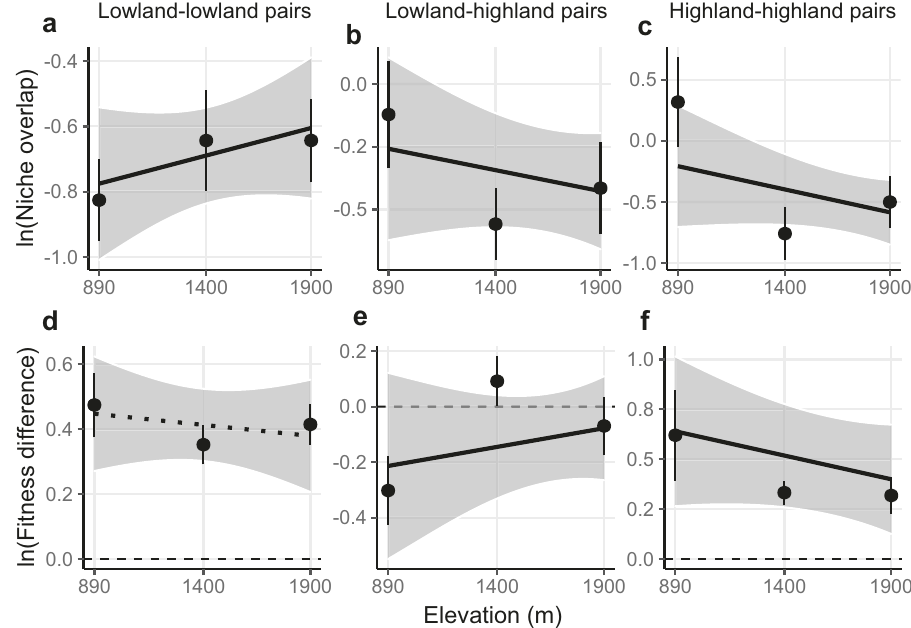
Fig. 3 Niche differences and relative fi tness differences across the elevation gradient. Estimates of the niche differences (expressed as niche overlap, i.e., 1 — niche differences; see Methods; fi rst row) and relative fi tness differences (second row) across the elevation gradient of lowland – lowland ( a , d ; n = 9, 10, and 10 pairs at the low, middle, and high elevations, respectively), lowland – highland ( b , e ; n = 14, 12, and 18 pairs at the low, middle, and high elevations, respectively) and highland – highland species pairs ( c , f ; n = 4, 5, and 8 pairs at the low, middle, and high elevations, respectively). Both niche overlap and relative fi tness differences are shown on a log scale. The points and error bars represent the averages and standard errors across species pairs at each site. Solid lines indicate a signi fi cant interaction of elevation × competitor identity for niche differences, and signi fi cant effects of elevation on relative fi tness differences for each type of pair separately (test based on the mean of bootstrap replicates; p < 0.05); the dotted line indicates a non- signi fi cant relationship ( p > 0.05; Supplementary Table 5). Shading indicates 95% con fi dence intervals for the regressions derived from bootstrap replicates of the dataset ( N = 500 bootstraps), indicating the propagated uncertainty in the relationships resulting from model parametrization (see Methods). In d – f , absolute values of fi tness differences are shown for lowland – lowland and highland – highland pairs, while actual values are shown for lowland – highland pairs, with negative values indicating lowland species are dominant competitors. Source data are provided as a Source Data fi